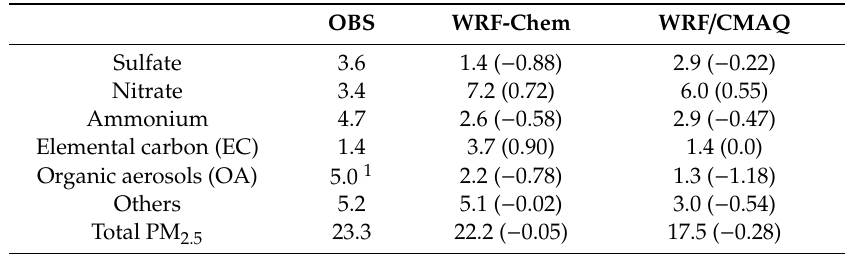
Table 2. The measured and simulated monthly mean PM 2.5 chemical components over Seoul, South Korea in April 2010. The numbers in parentheses denote the fractional